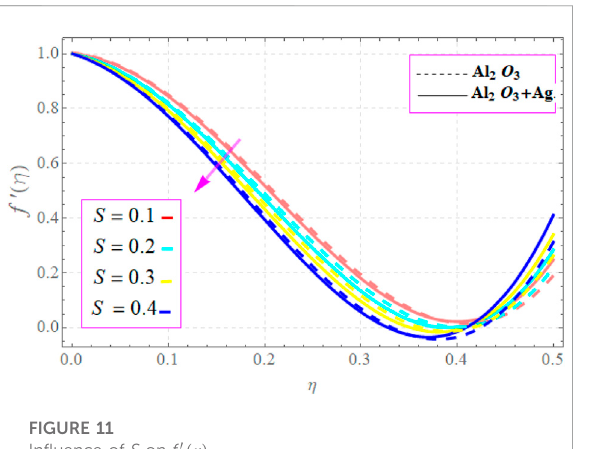
FIGURE 11 In fl uence of S on f ′ ( η ) .